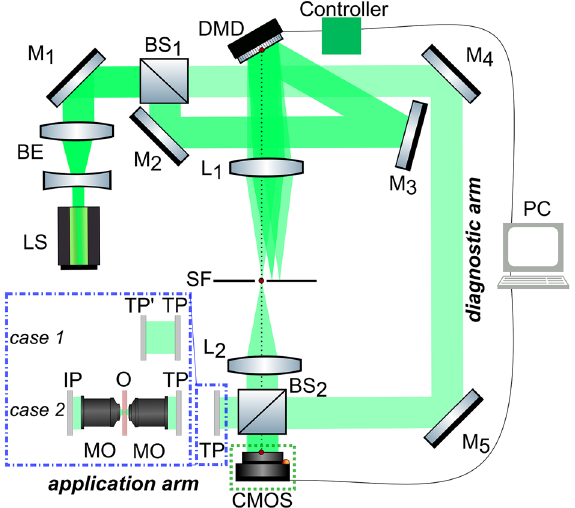
Figure 1. Experimental setup scheme. BE is a beam expander, M 1 − 5 are mirrors, S is a shutter, BS 1 − 2 are beam splitters, L 1 − 2 are lenses, SF is a spatial filter, TP is a target plane, CMOS is matrix detector, MO are objectives, IP is an image plane, O is an